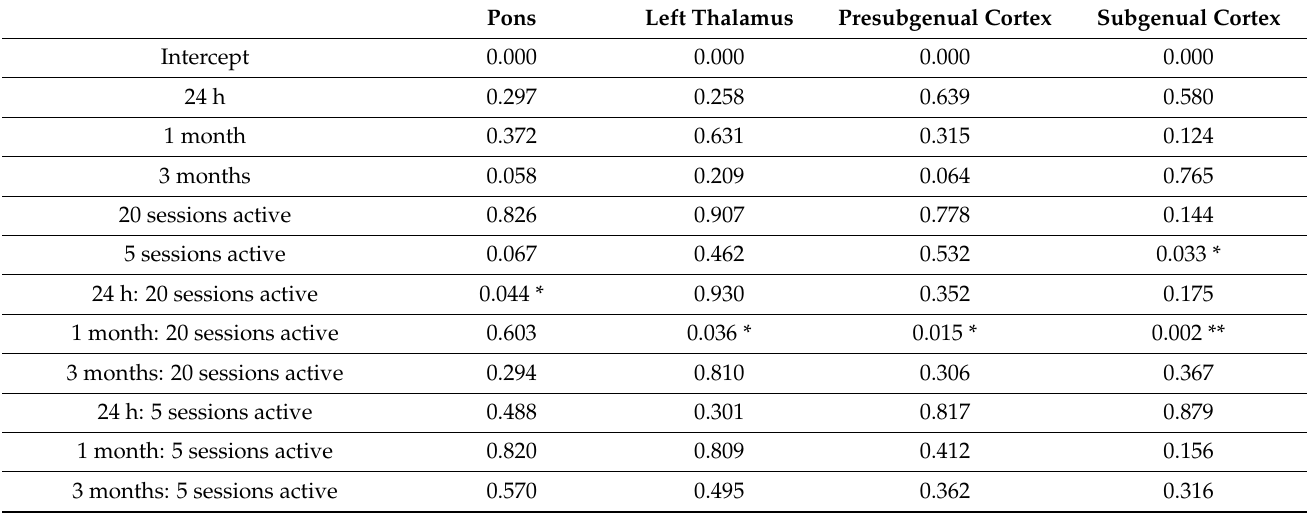
Table 1. Output main effect and interaction test for the predictors time and treatment group. Pons Left Thalamus Presubgenual Cortex Subgenual Cortex Intercept 0.000